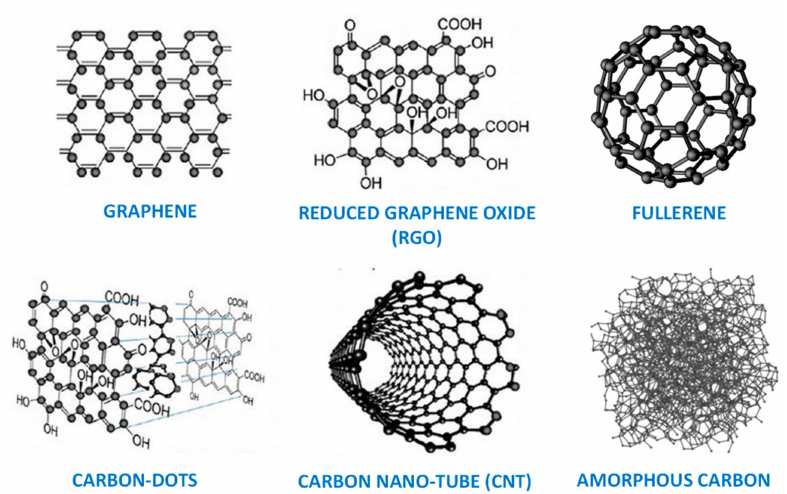
Figure 7. Structure of the most common carbon-based nanostructured materials.